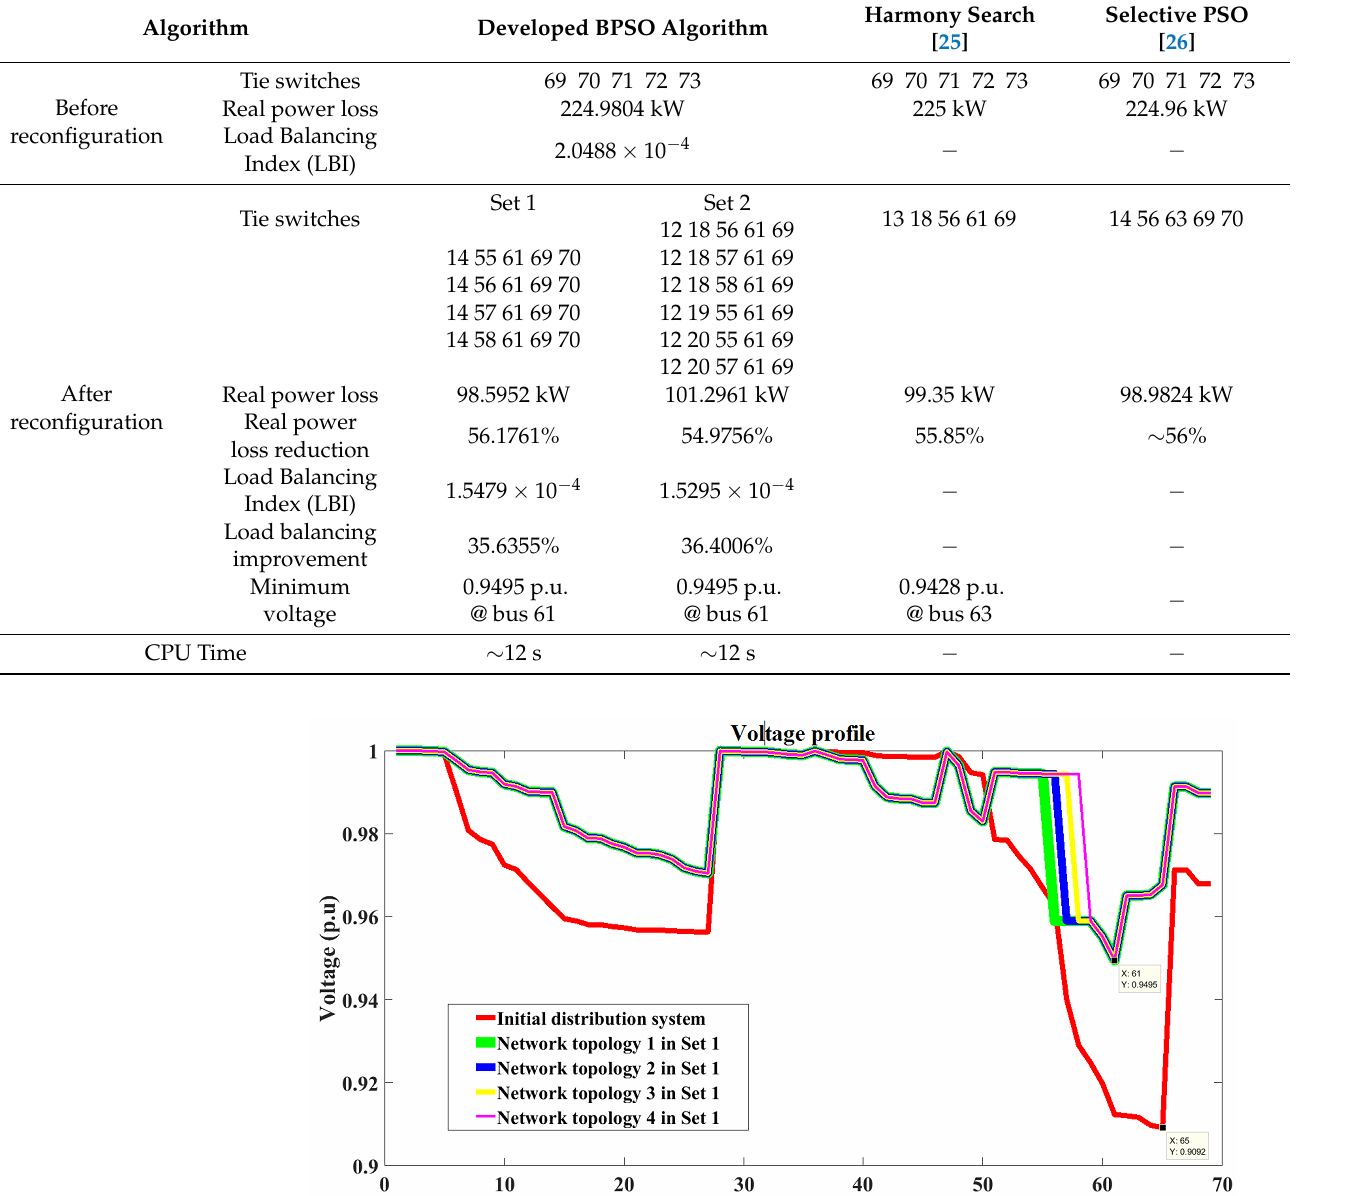
Table 4. Simulation findings for the 69-bus distribution system’s multi-objective feeder reconfigura- tion problem.